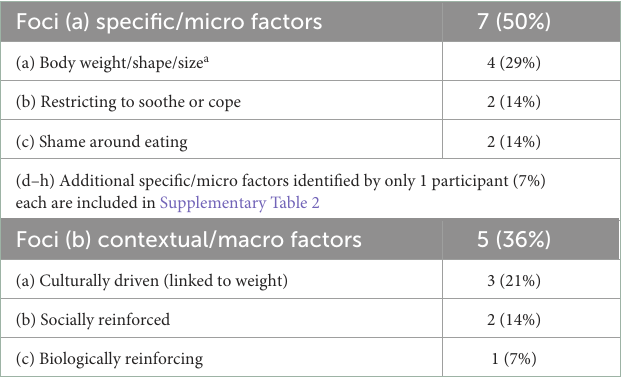
TABLE 7 Participant statements consistent with theme 2, subtheme iii, “factors contributing to restriction” (71%). Foci (a) specific/micro factors